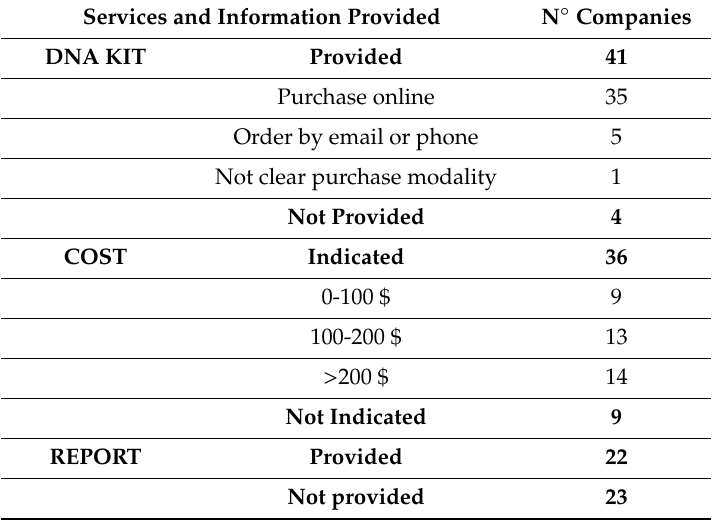
Table 2. Services and information provided by the selected companies.